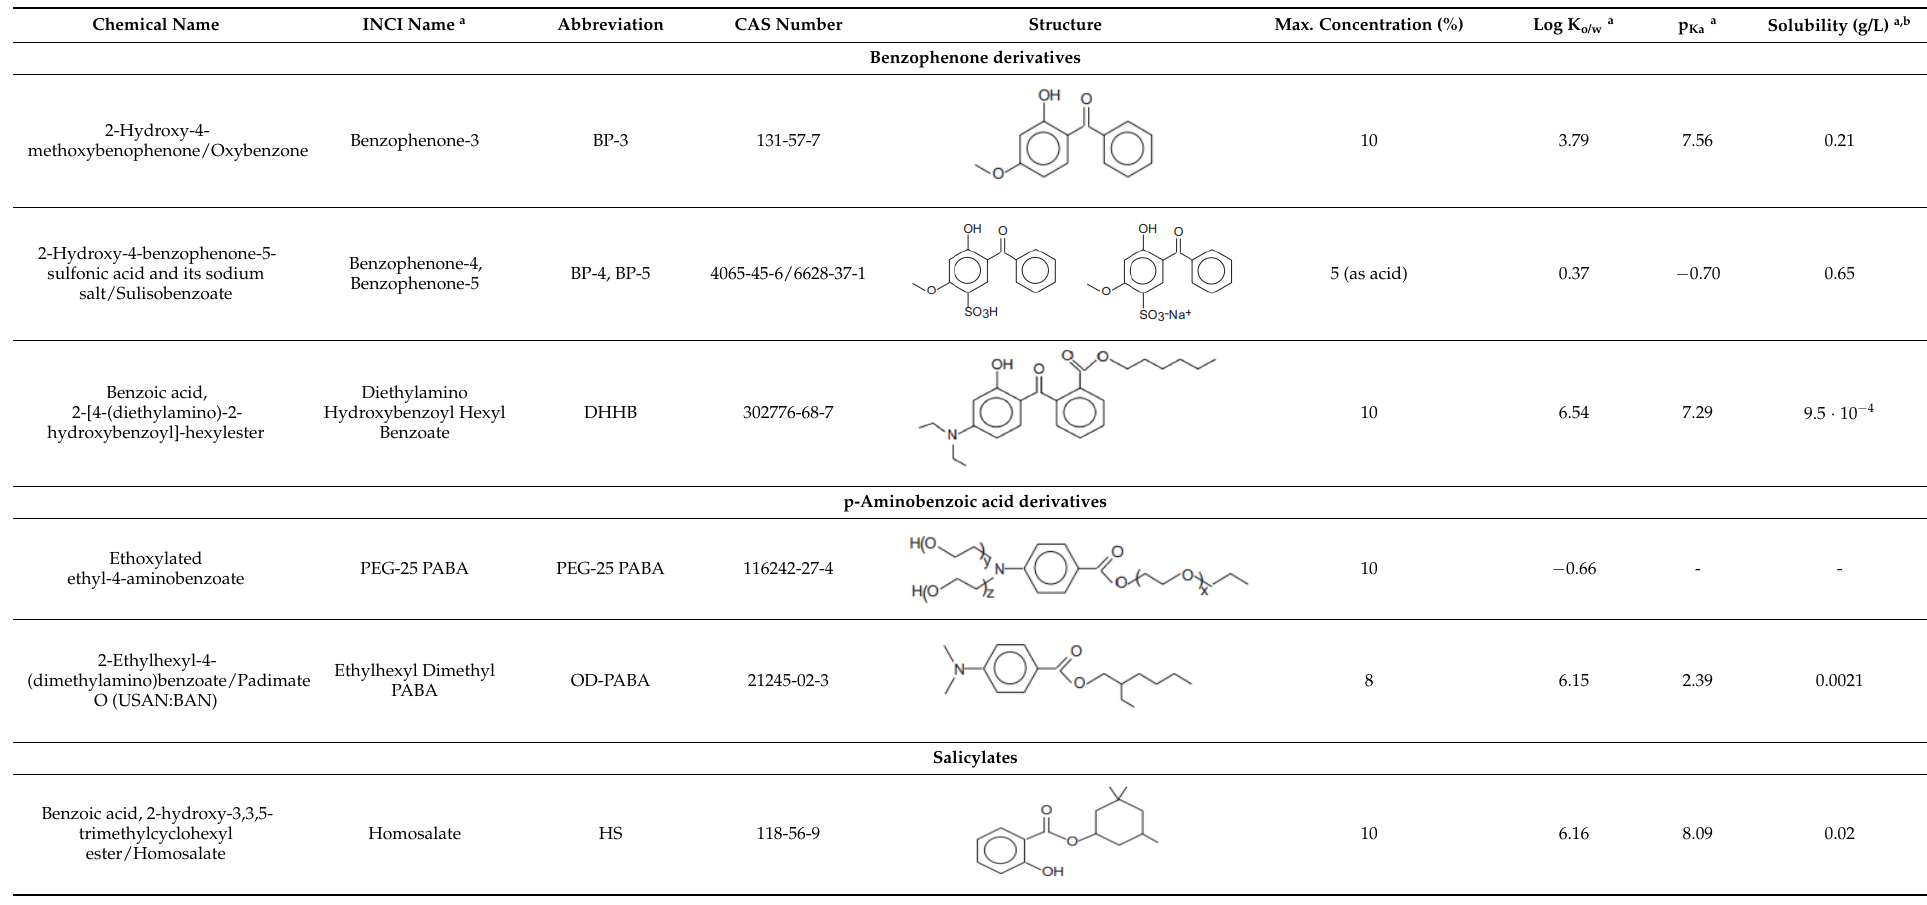
Table 1. List of compounds that can be allowed as organic UV filters in cosmetic products according to the European Union legislation.